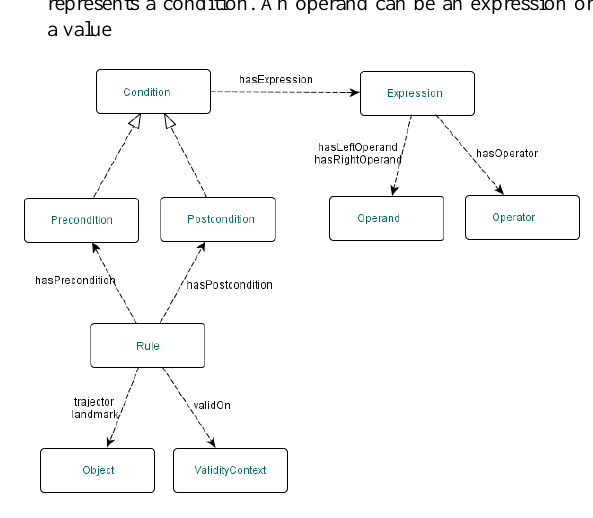
Figure 2a. Main components of the rule model Figure 2b gives and a more detailed view of the expression part: